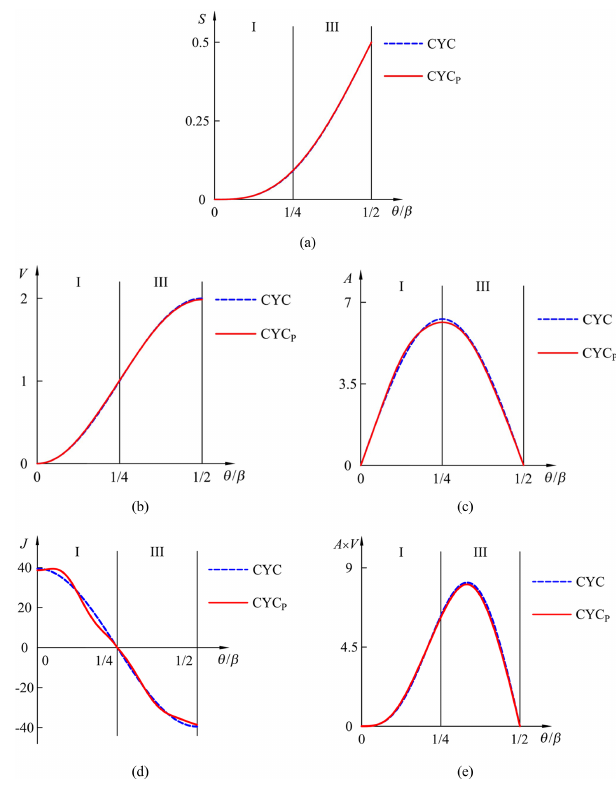
Figure 5. Variation in normalized motion program in Example